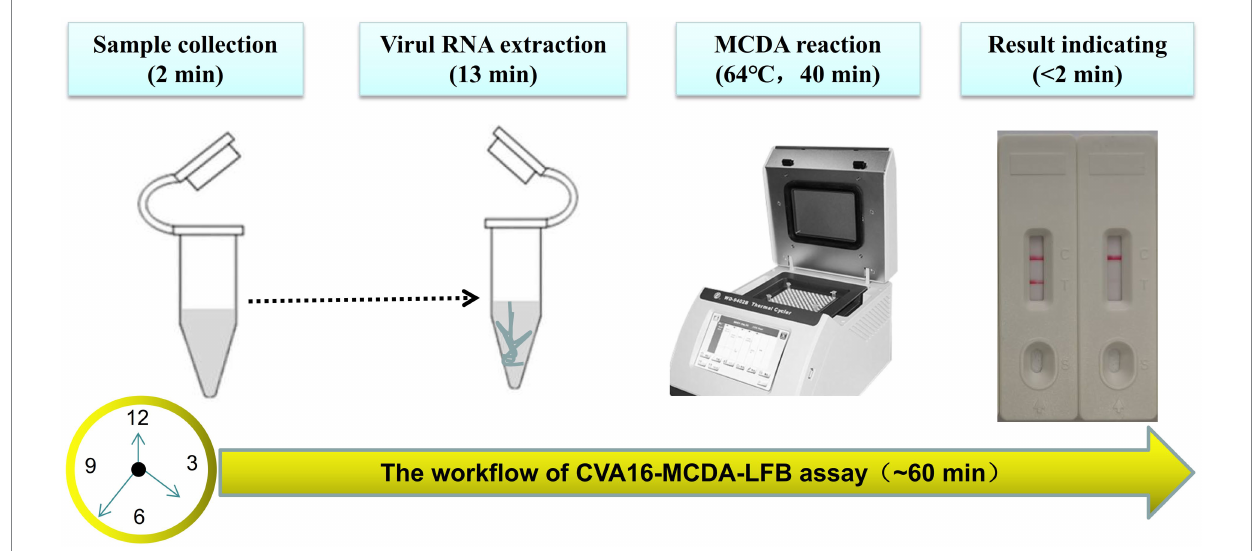
FIGURE 6 The workflow of CVA16-MCDA-LFB assay. Four steps, including sample collection (2 min), Virul RNA extraction (13 min), MCDA reaction (40 min) and result reporting (<2 min), are required for the CVA16-MCDA-LFB assay, and the total procedure can be completed within 60